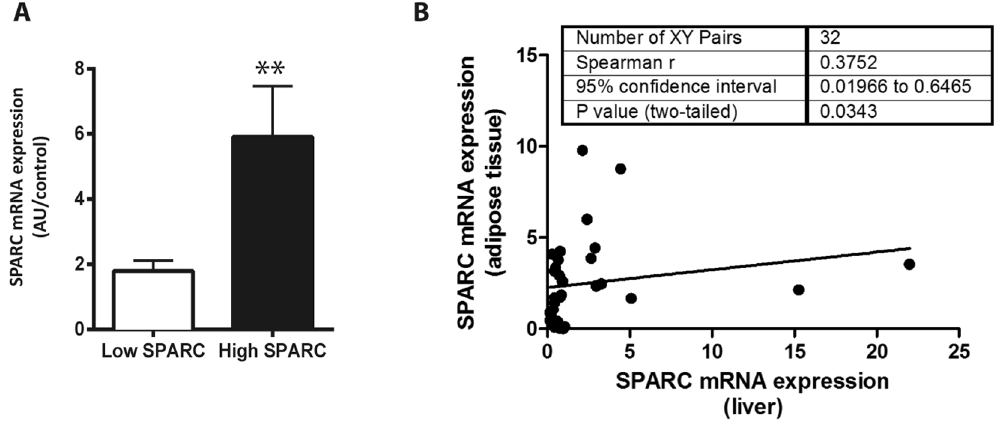
Figure 3. SPARC expression in adipose tissue and liver tissue are correlated. NAFLD patients were grouped by hepatic SPARC mRNA expression. Patients with high hepatic SPARC expression also had significantly higher SPARC mRNA expression in adipose tissue ( A ). Data are mean ± sem, ** p < 0.01, Mann-Whitney U Test. mRNA expressions of SPARC in both sites were significantly correlated to each other ( B ). Spearman rank test.